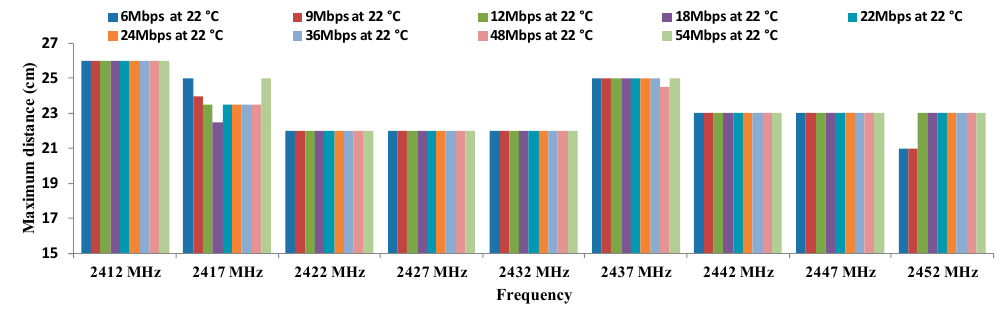
Figure 14. Maximum distances for OFDM at 22 °C.